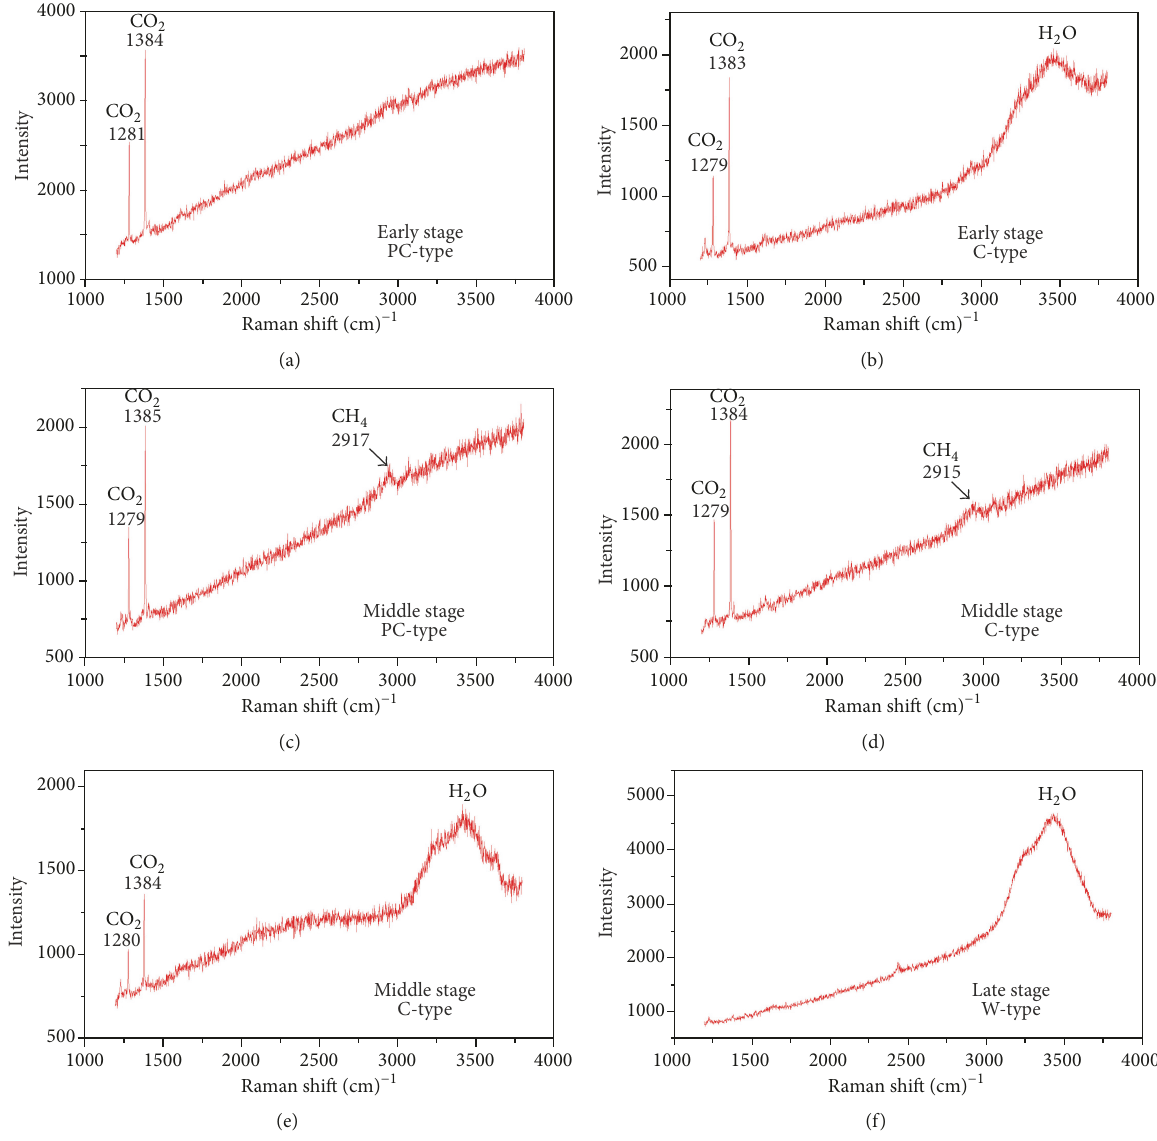
Figure 9: Representative Raman spectra of fluid inclusions in the Liyuan gold deposit. (a) CO 2 spectra of vapour in PC-type inclusions of the early stage; (b) H 2 O and CO 2 spectra of vapour in C-type inclusions of the early stage; (c) CO 2 and CH 4 spectra of vapour in PC-type inclusions of the middle stage; (d) CO 2 and CH 4 spectra of vapour in C-type inclusions of the middle stage; (e) CO 2 and H 2 O spectra of vapour in C-type inclusions of the middle stage; (f) H 2 O spectra of vapour in W-type inclusions of the middle